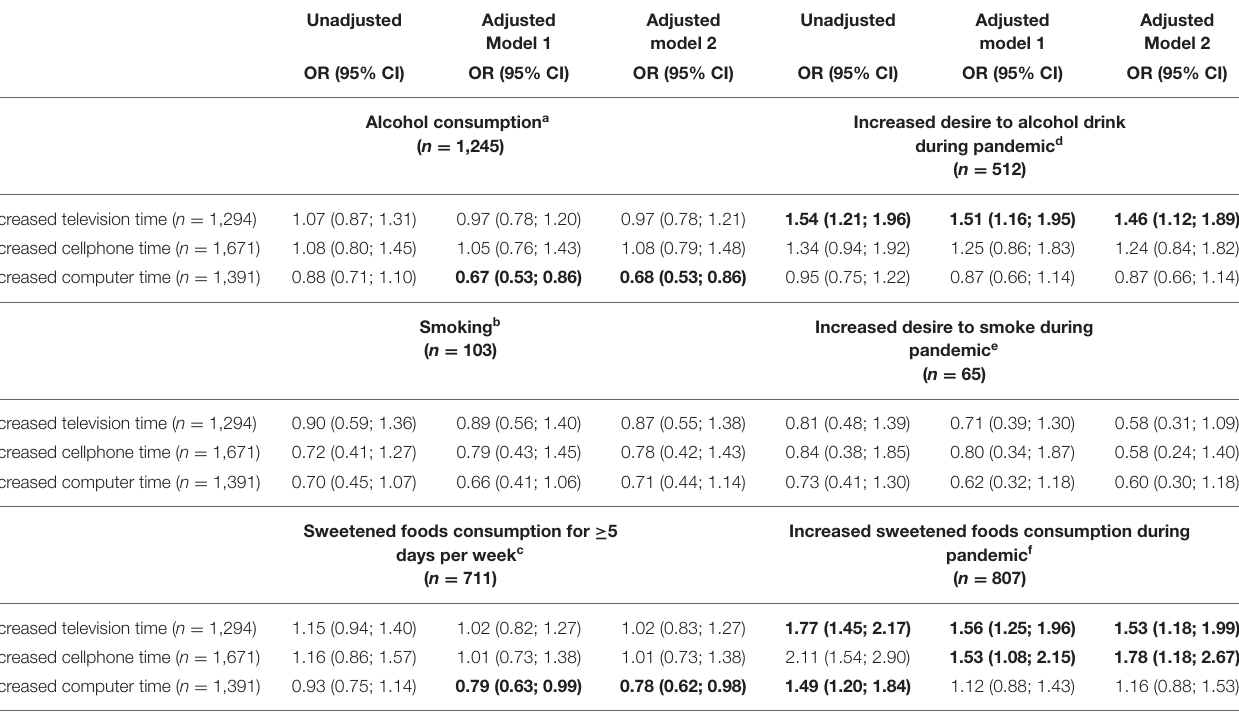
Model 1: Adjusted by age, sex, educational level, feeling of stress, feeling of anxiety, feeling of depression, use of screen device for physical activity, and total screen time per day in each device; Model 2: Model 1 + adjusted mutually by a, b, and c, or by d, e, and f, according to the column; OR, odds ratio; CI, confidence interval. Bold values were statistically significant at p < 0.05